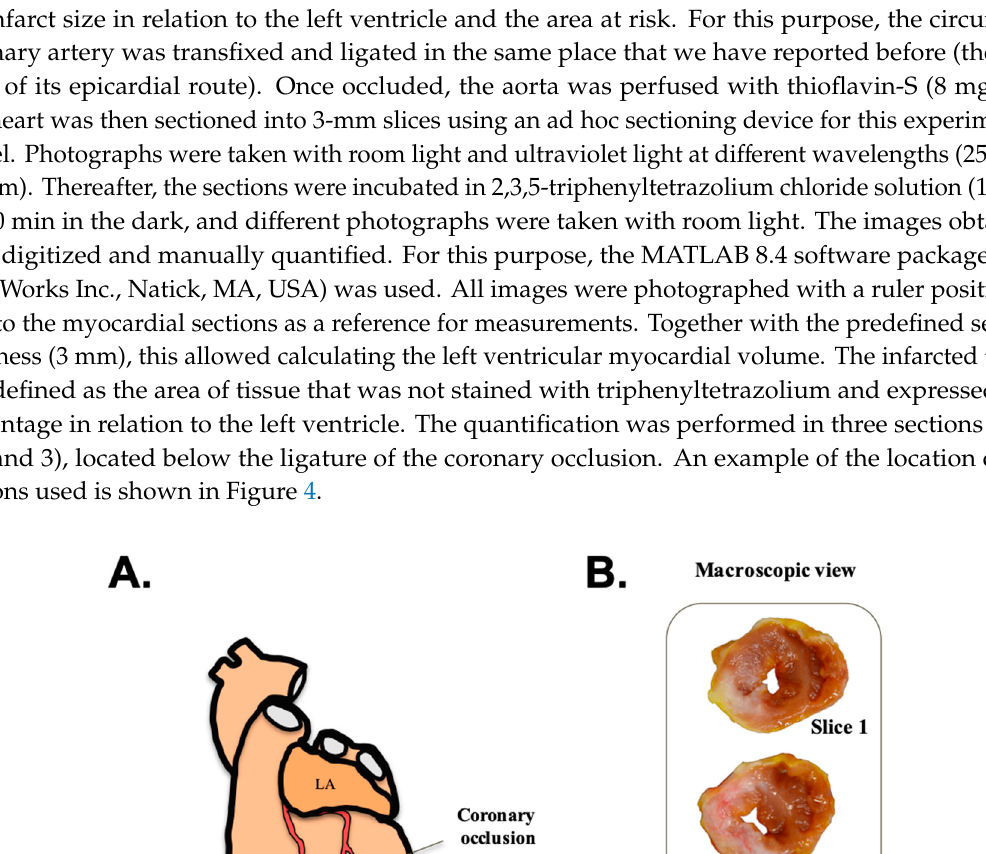
Infarcted area Areaat risk